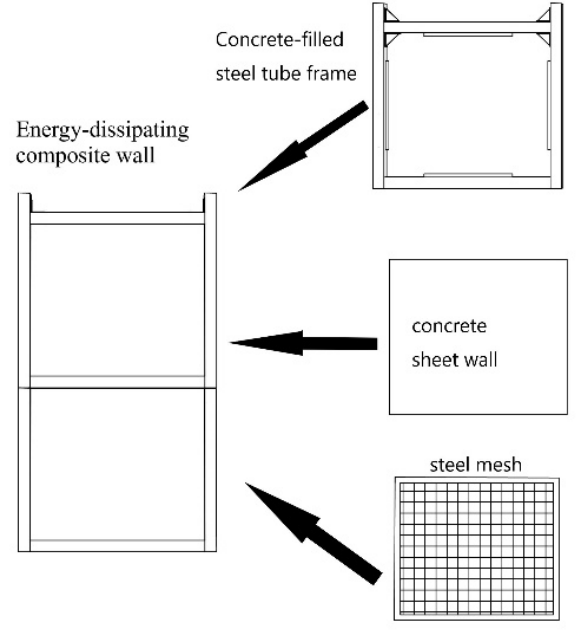
Figure 2. Composition of the EDCW. Table 1. Mechanical parameters of the boundary components of the EDCW.